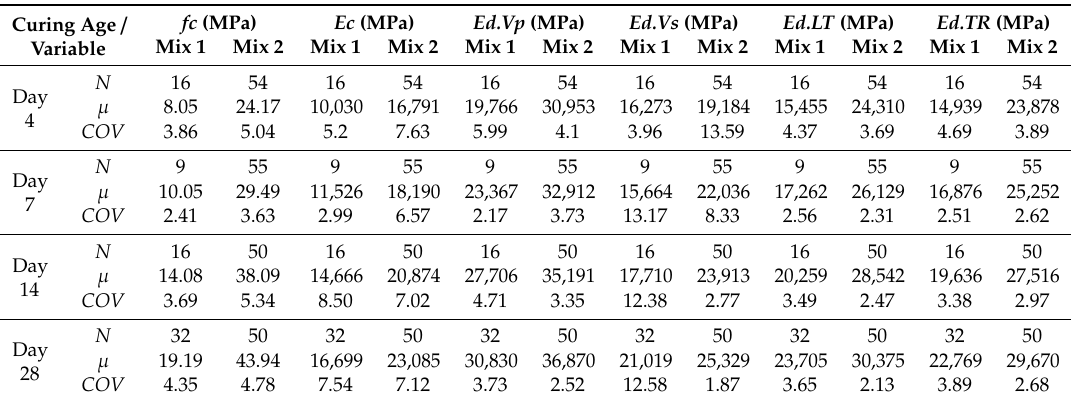
Table 2. Summary of statistical analysis.